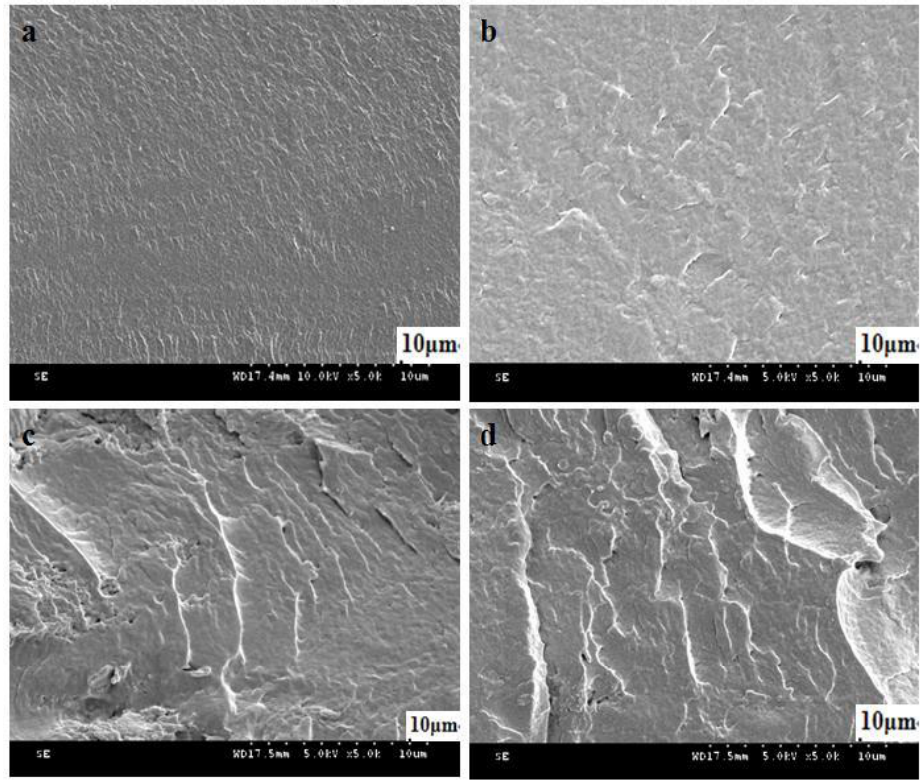
Figure 2. SEM image of the cross-section: ( a ) CS. ( b ) CS-DCNC-AgNPs (3%). ( c ) CS-DCNC-AgNPs (5%). ( d ) CS-DCNC-AgNPs (10%).